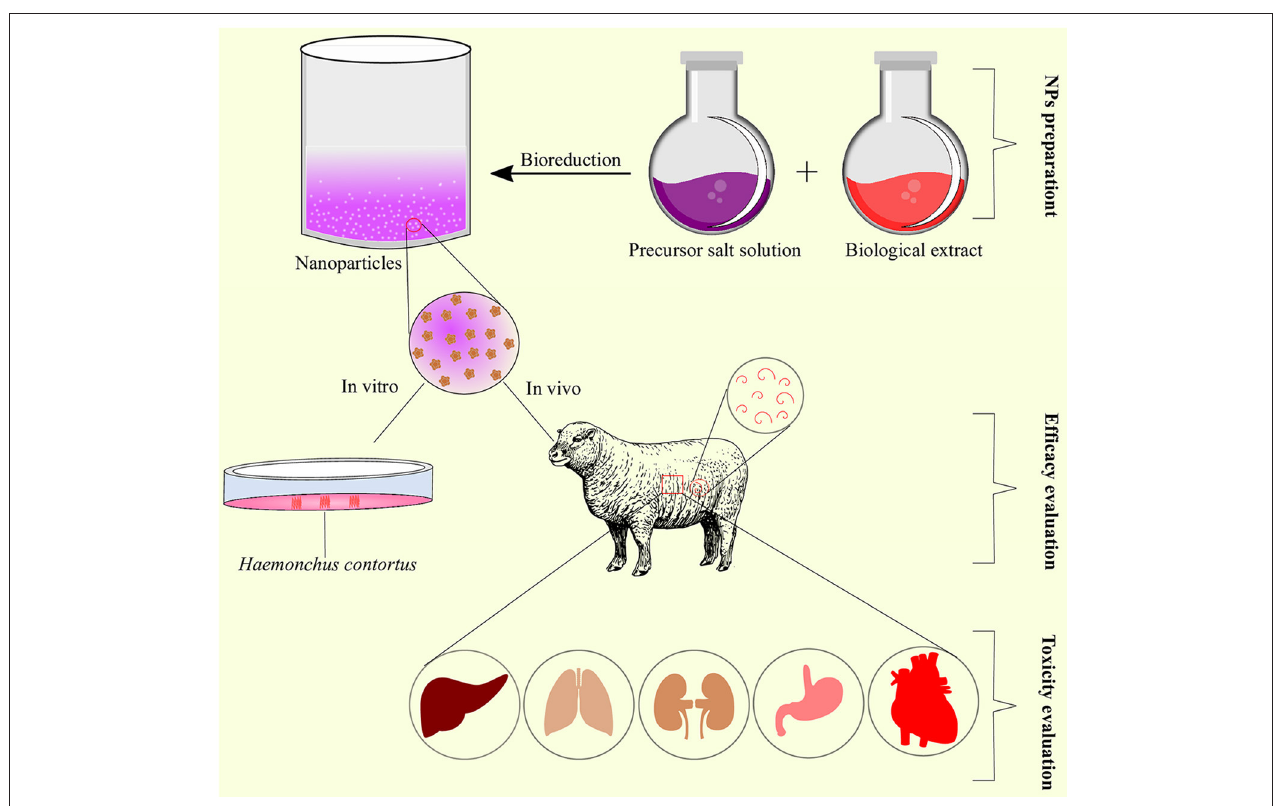
FIGURE 5 | Schematic representation of nanoparticles preparation, efficacy, and toxicity evaluation as anthelmintic